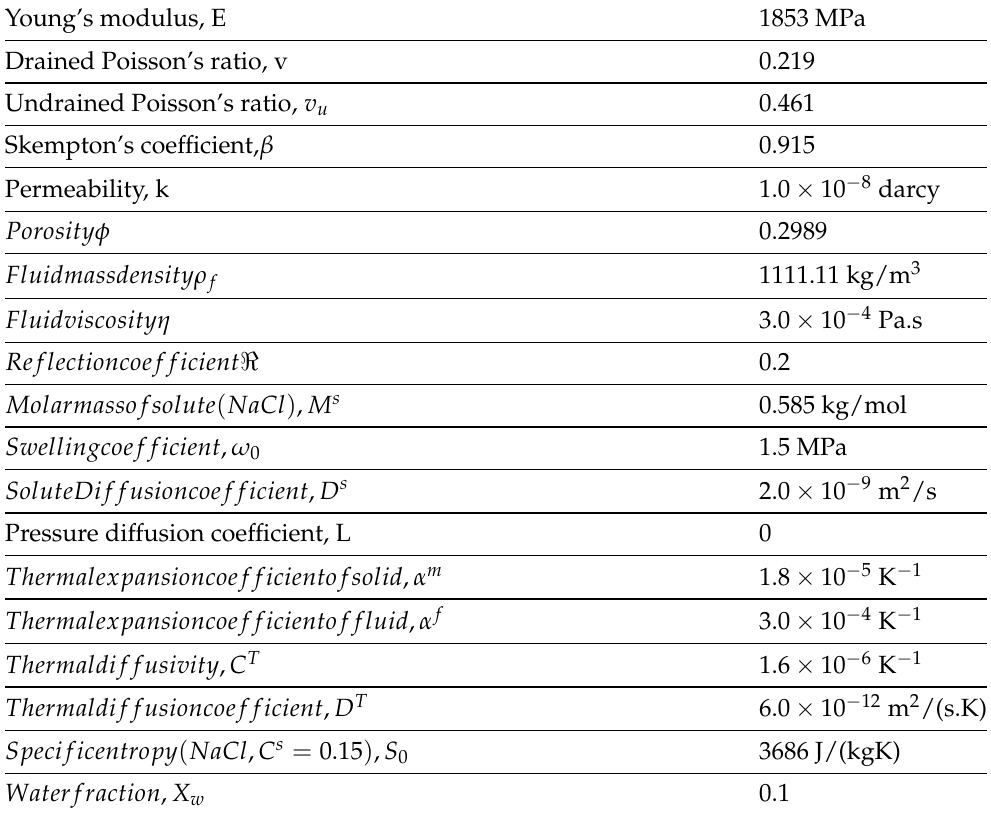
Table A3. Typical Properties of Shale Rock Used in the Numerical